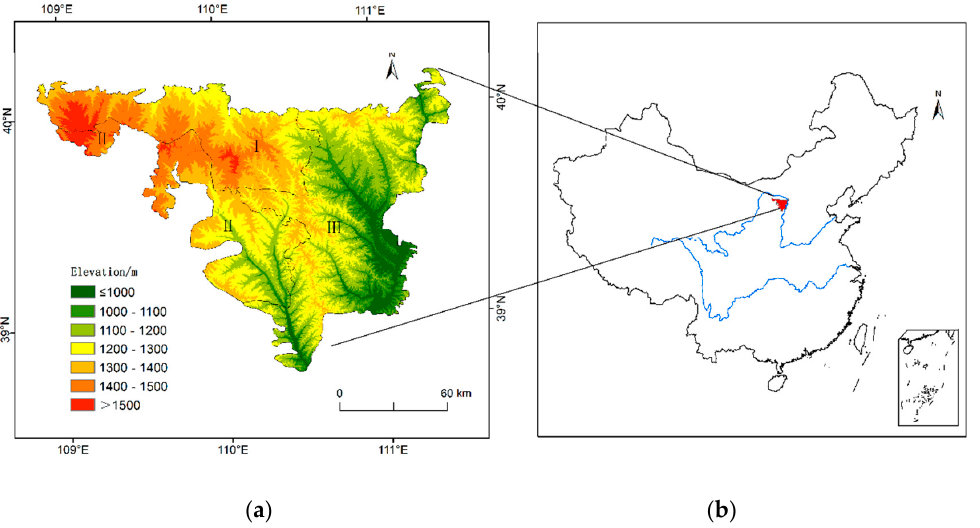
Figure 1. Elevation ( a ) and location ( b ) of the Pisha Sandstone area. I: Bare Pisha Sandstone area; II: Sand-covered Pisha Sandstone area; III: Soil-covered Pisha Sandstone